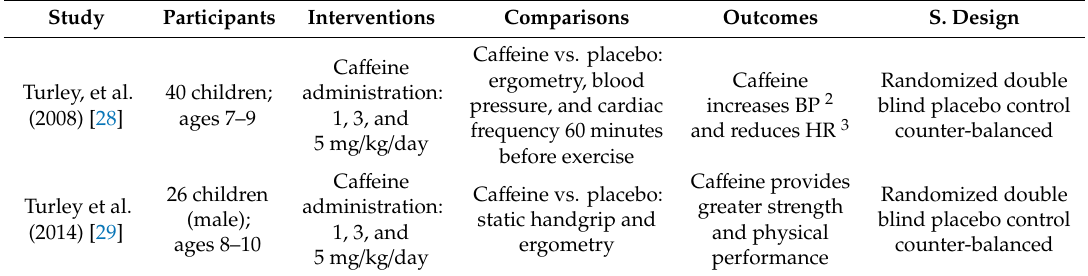
Table 5. Description of analyzed studies on physical activation, according to the PICOS 1 method. Study Participants Interventions Comparisons Outcomes S. Design Turley, et al.